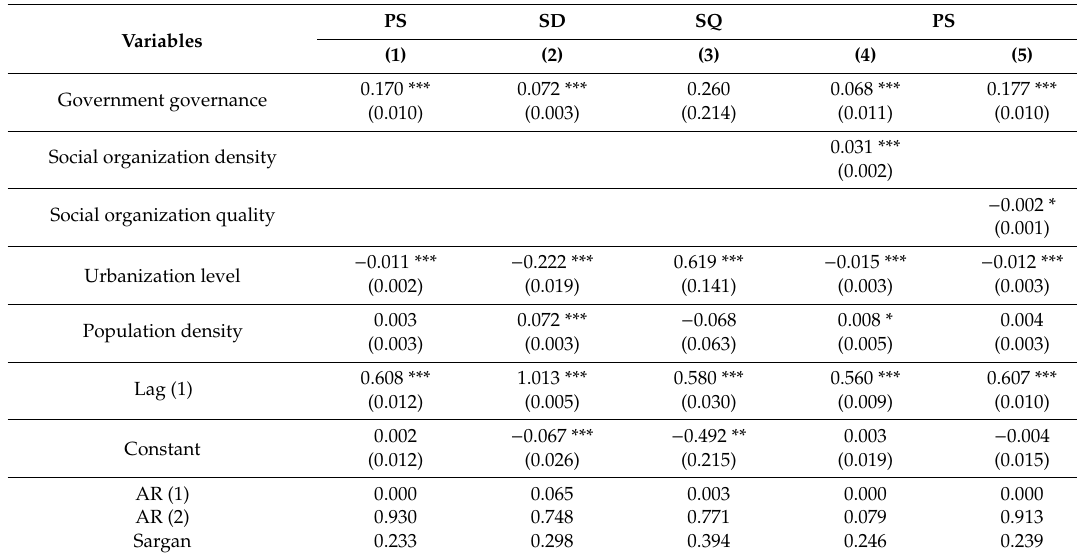
Table 6. Mediation e ff ect analysis